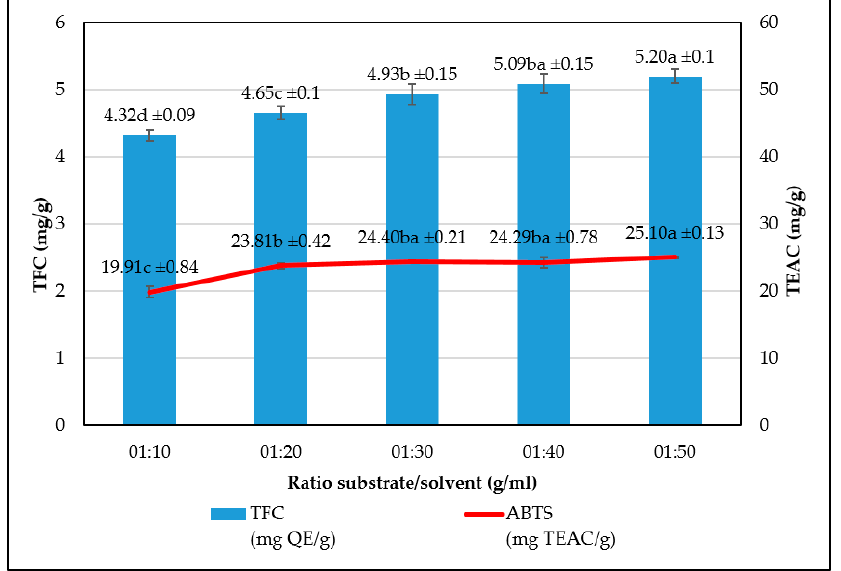
Figure 4. The effect of ratio substrate/solvent to extraction process. Figure 4. The e ff ect of ratio substrate / solvent to extraction